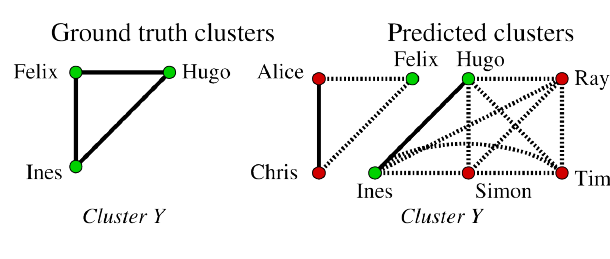
Figure 4: Ground-truth singleton J